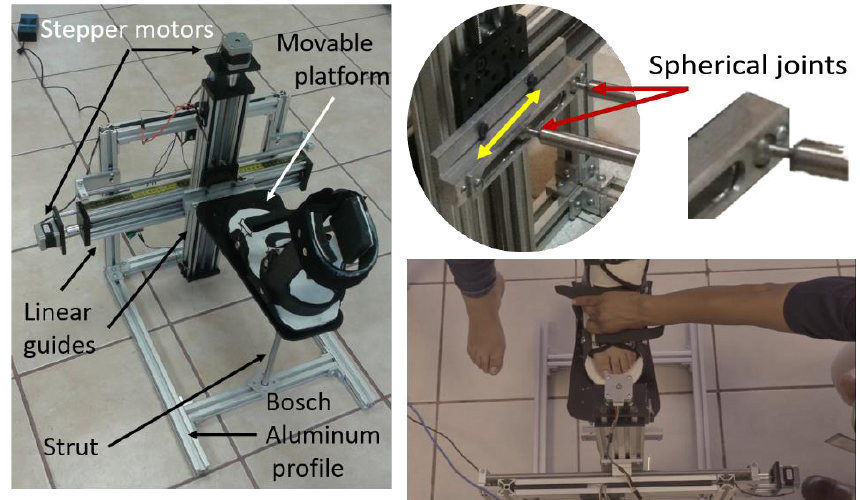
Figure 3. Ankle rehabilitation machine.